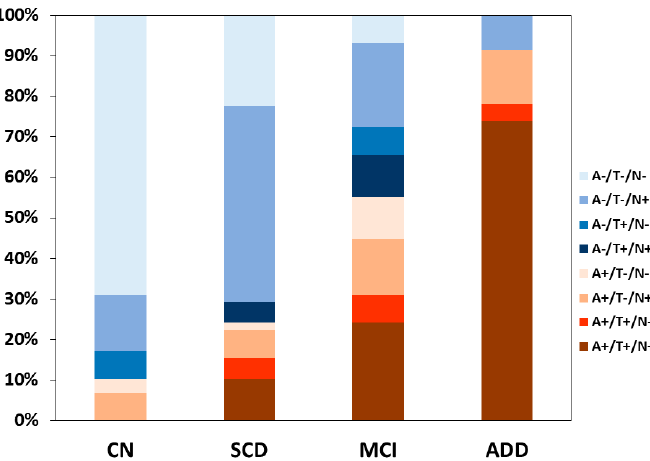
Figure 2. A stacked bar graph showing the proportions of ATN categories within each diagnostic group among the KBASE-V participants with cerebrospinal fluid (CSF) AD biomarker results. The proportion of participants in the Alzheimer's continuum (A+/T+/N+, A+/T+/N − , A+/T − /N+, and A+/T − /N − ) was 10.3% in the CN group, 24.1% in the SCD group, 55.1% in the MCI group, and 91.3%